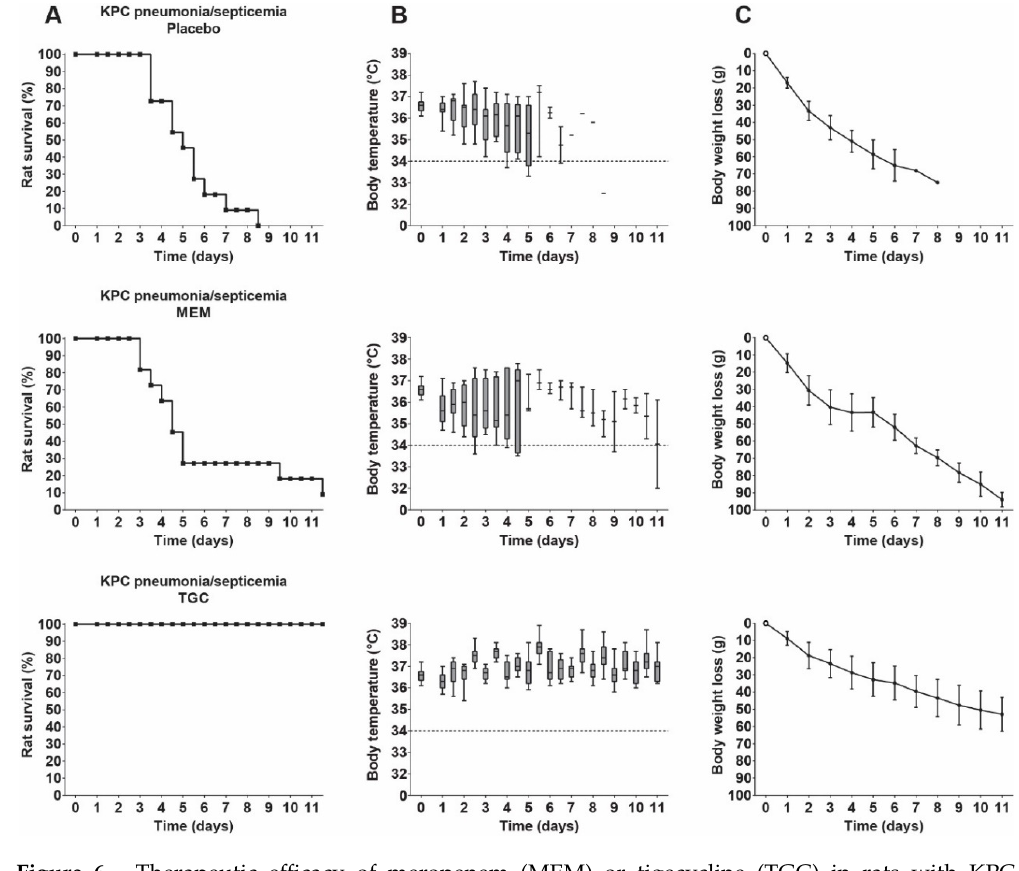
Figure 6. Therapeutic efficacy of meropenem (MEM) or tigecycline (TGC) in rats with KPC Therapeutic e ffi cacy of meropenem (MEM) or tigecycline (TGC) in rats with pneumonia–septicemia. Groups of 11 rats were treated 12-hourly for 10 days with placebo (physiological saline), 25 mg/kg/day meropenem, or 25 mg/kg/day tigecycline, starting at 24 h after initiation of infection. ( A ) Rat survival (Kaplan–Meier curves) of rats reaching humane endpoints. ( B ) Box plots of pooled body temperatures showing the range of the data; the dashed line at 34 °C represents the humane endpoint. ( C ) Body weight loss (mean ± SD).